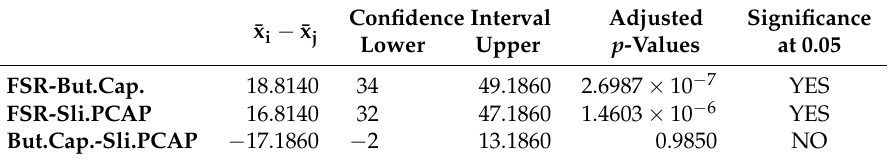
Table 6. Dunn & Sidak Post-Hoc Analysis for